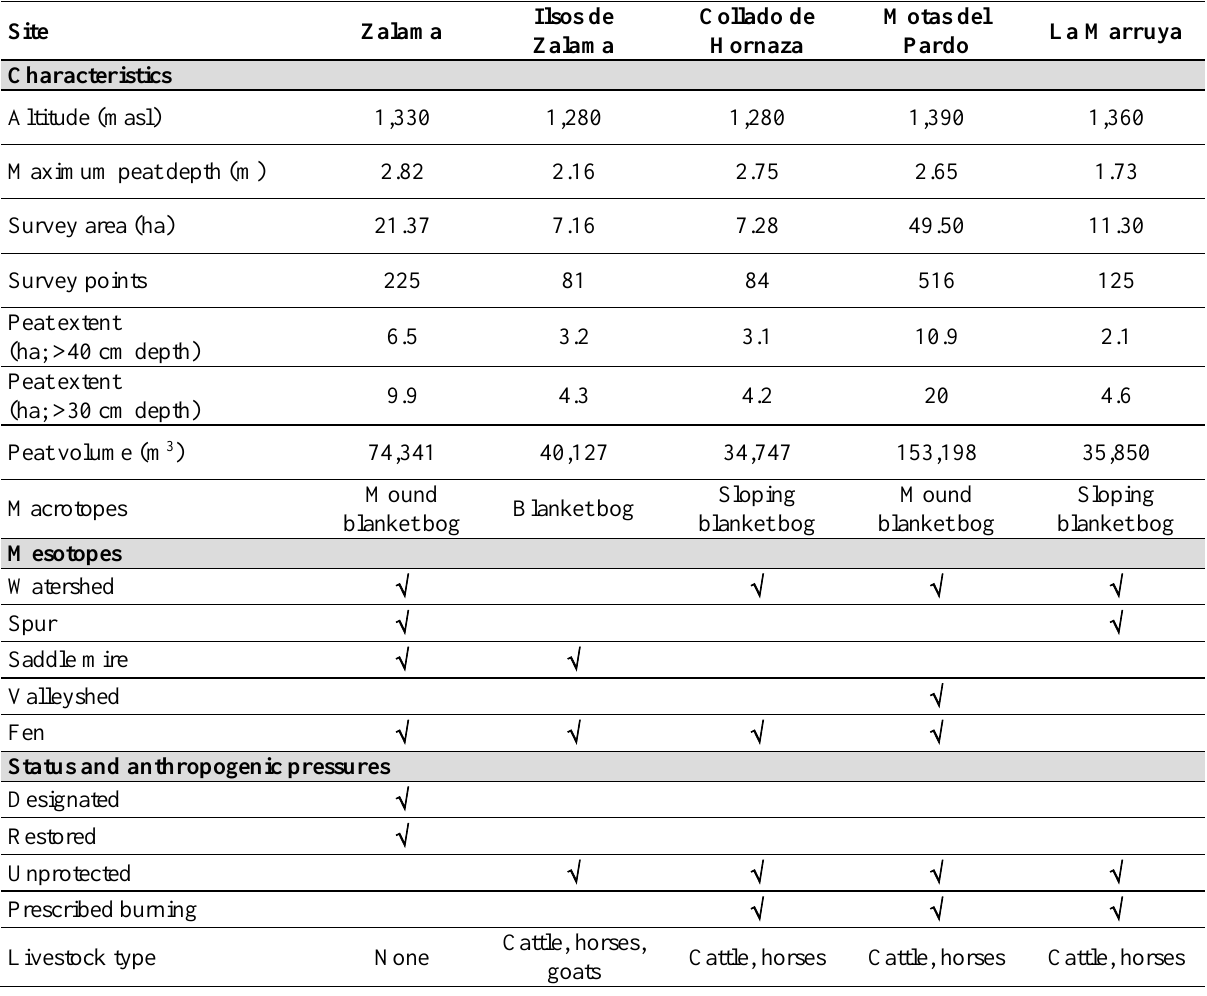
Table 1. Characteristics of the studied blanket